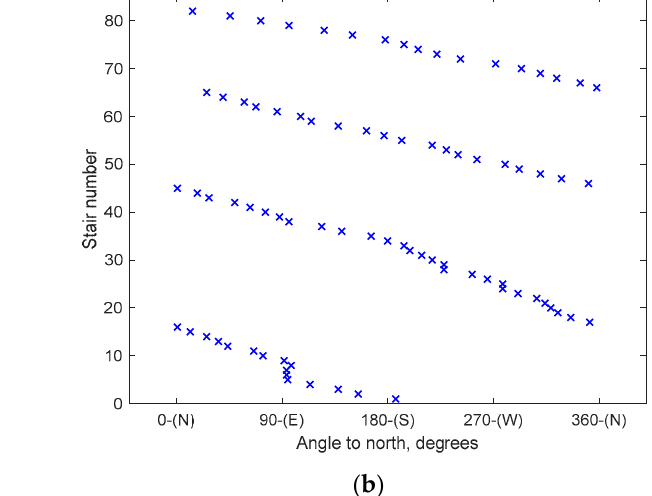
Figure 8. Measurements of each stair’s orientation: ( a ) typical measurement (stair no. 48 is shown); ( b ) angles of all stairs.